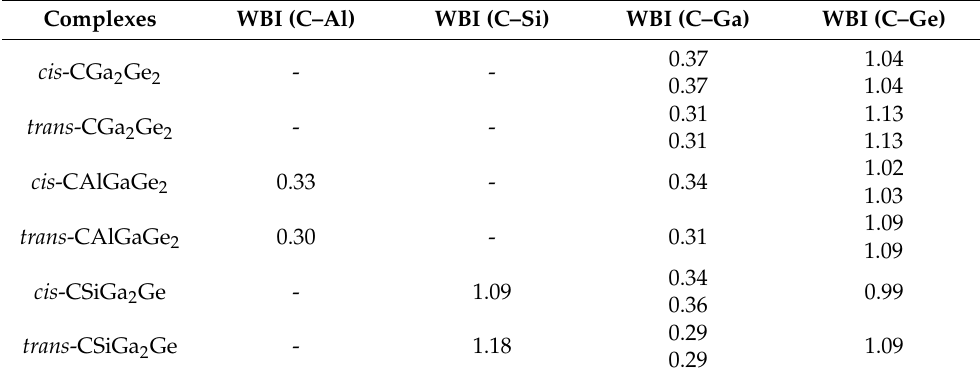
Table 2. Wiberg bond indices (WBI) for some selected bonds in the ptC molecules.